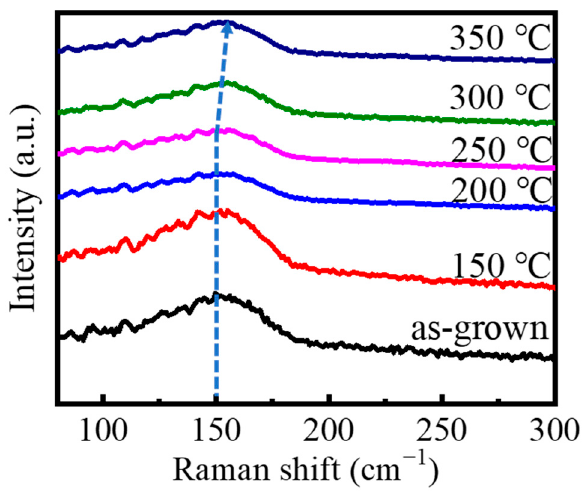
Figure 3. Raman spectrum of the as-grown GST films annealed at different temperatures for 30 min.